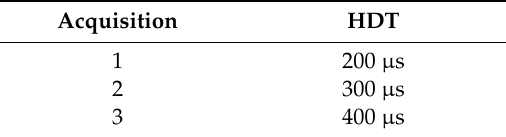
Figure 7. Transducer arrangement for evaluation of AE entropy against the hit definition time (HDT). Table 3. HDT for each channel.